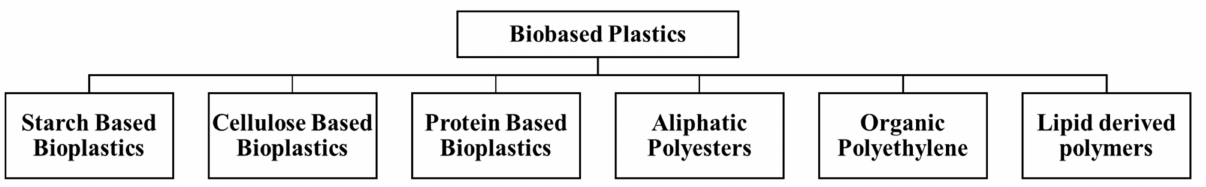
Figure 11. The sources of biobased